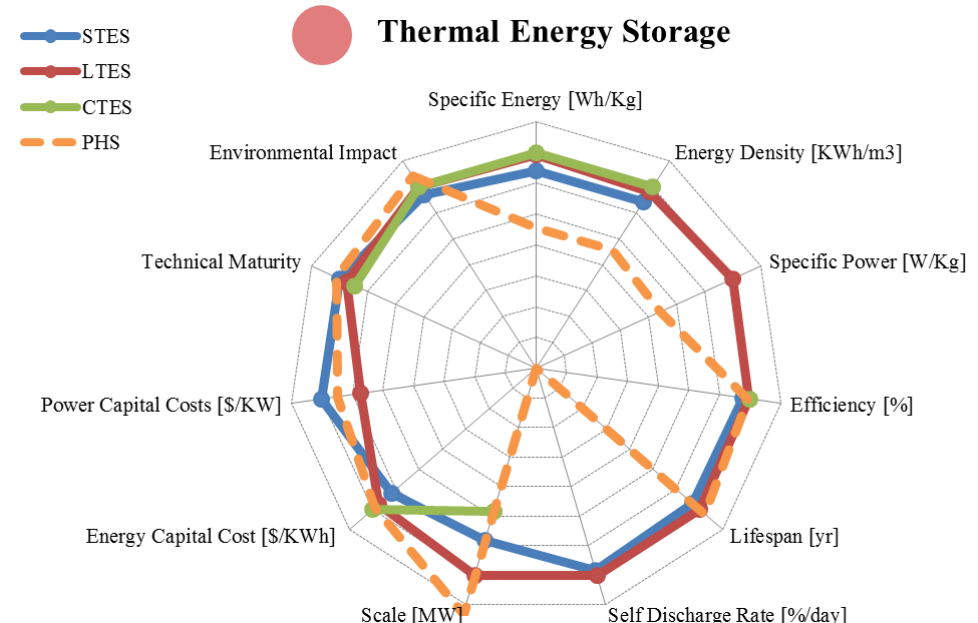
Figure 11. Comparing thermal storage using normalized and logarithmically plotted average data from Table 10